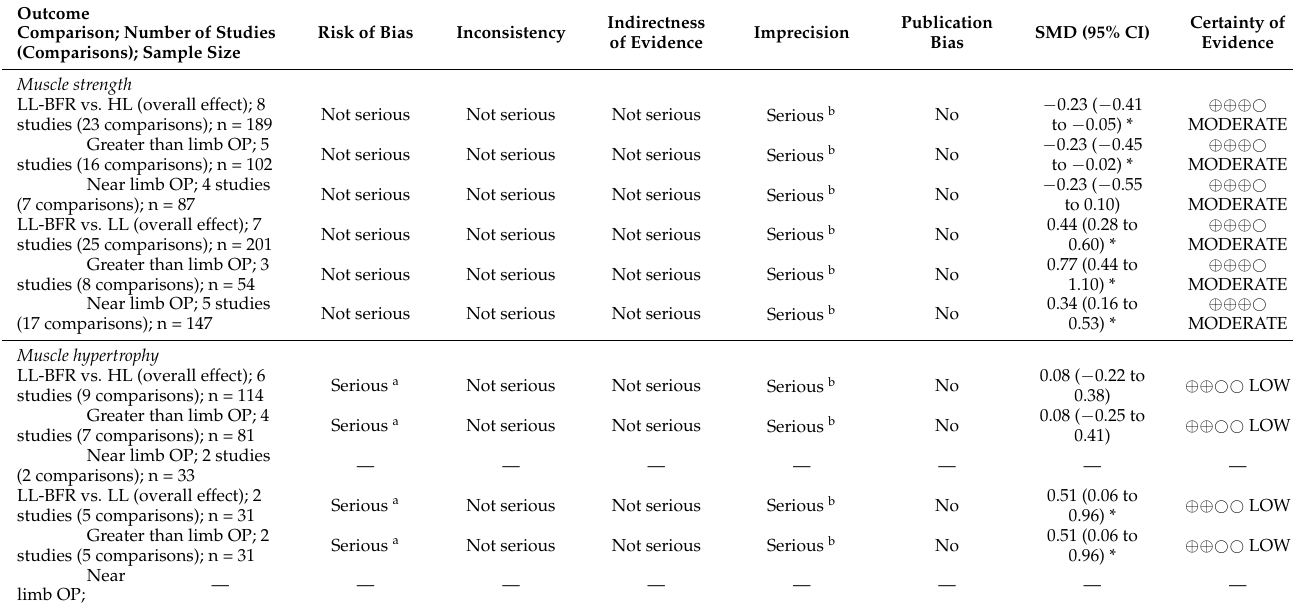
Table 3. GRADE evidence profile for the effects of low-load blood flow restriction training. Risk of